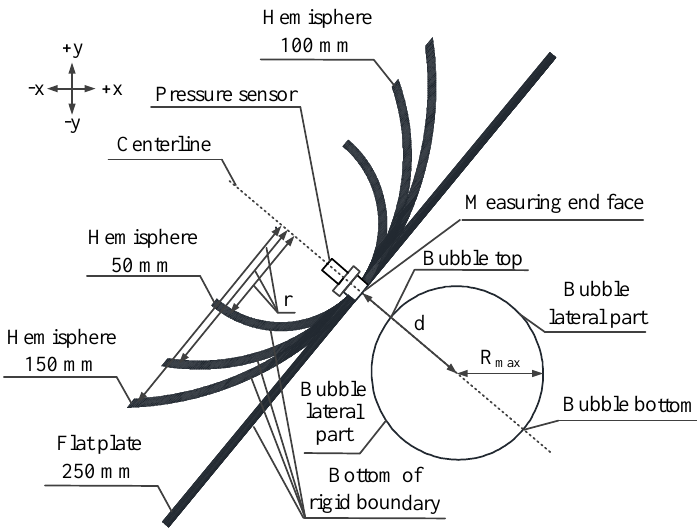
Figure 1. A cross section of the rigid oblique 45-degree curved surface boundary structure. The measuring surface radius of the 37,311 pressure sensor is 0.03 m, as shown in Figure 2. According to the formula S = π r 2 , the area of the sensor measuring surface is 0.002826 m 2 . The radii of the three hemispherical structures are 25, 50, and 75 mm. According to the formula S = π r 2 , the surface areas of the three hemispherical structures were 0.19625, 0.785, and 1.76625 m 2 . Therefore, the ratio of the measuring surface of the sensor to the surface area of the three hemisphere structures was 1.4%, 0.3%, and 0.1%, respectively. Because the proportion is relatively small, it is still assumed in the experiment that the combination of the sensor and the hemisphere creates a complete hemispherical structure. The details are shown in Figure 3.